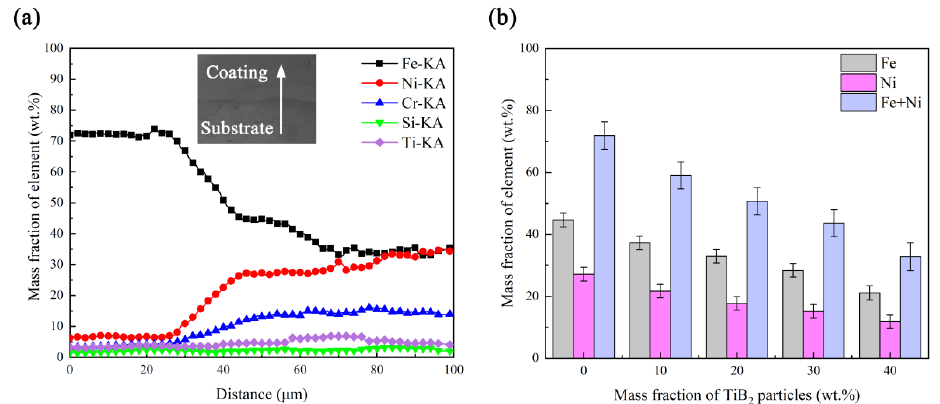
Figure 12. ( a ) Element distribution of coating TB0 and ( b ) partial element distribution of coatings with different TiB 2 particles contents near the coating/substrate interface.